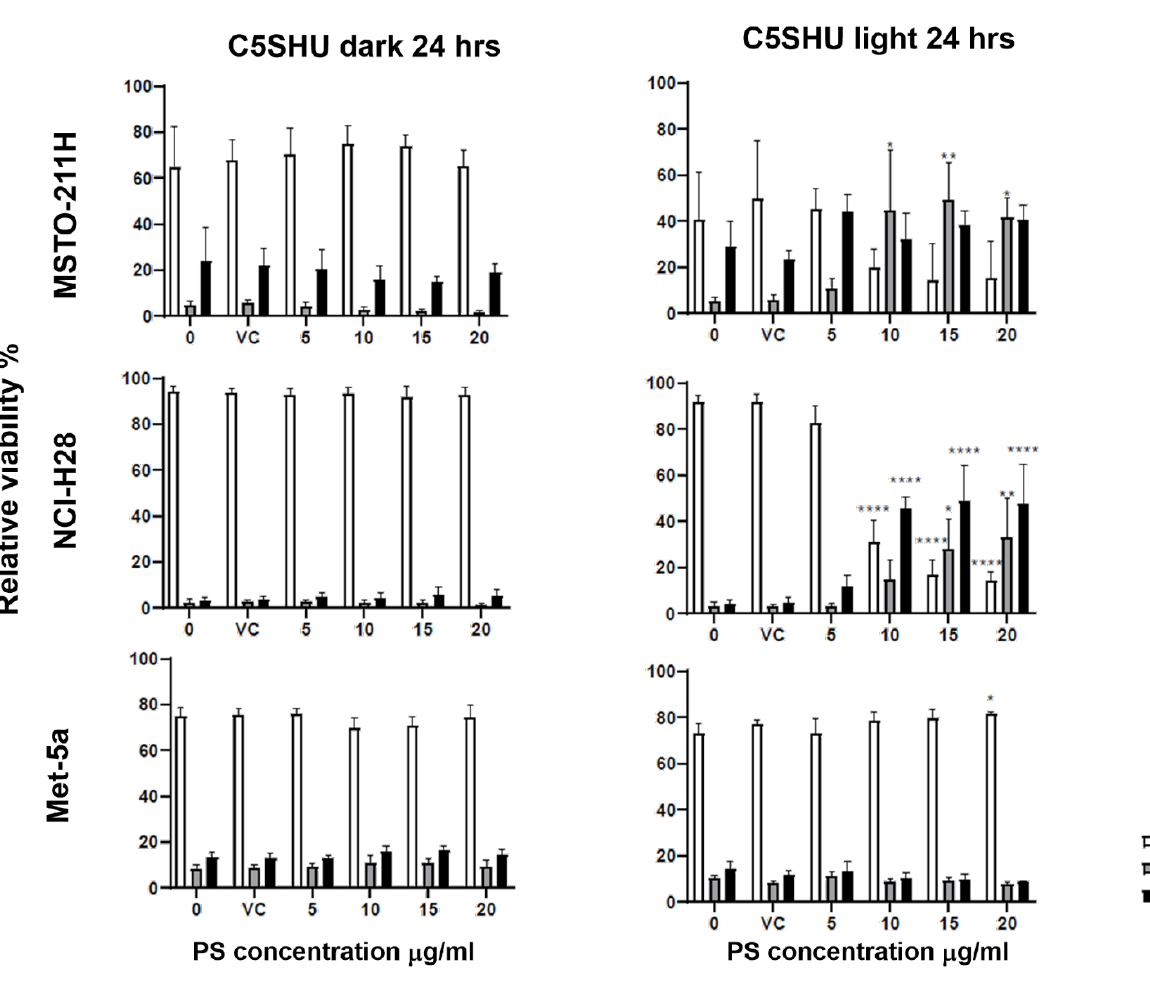
Figure 7. Cell death analysis of C5SHU-treated MSTO-211H, NCI-H28, and Met-5a cells as deter- mined by the Annexin V-FITC/PI assay 24 h after treatment. Results are expressed as the mean ± SD of three independent experiments. The varying significance of viable populations relative to that of the untreated control are indicated by *( p ≤ 0.05), **( p ≤ 0.01), ***( p ≤ 0.001), and ****( p ≤ 0.0001).